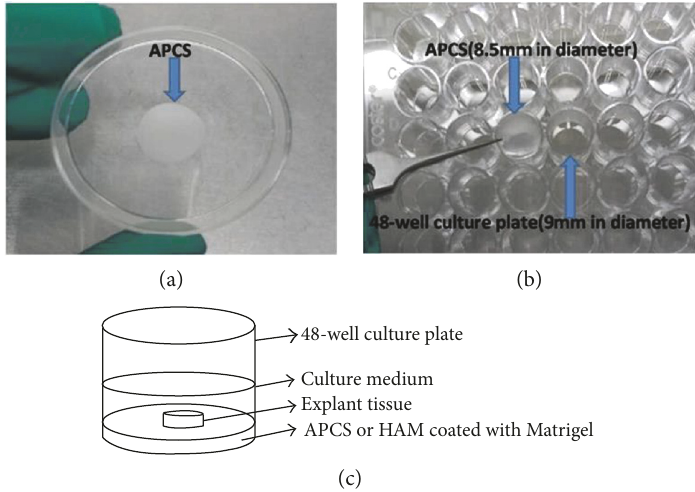
Figure 1: (a), (b) 48-well plate with 9mm well diameter and APCS with 8.5mm in diameter. (c) Explant tissue culture